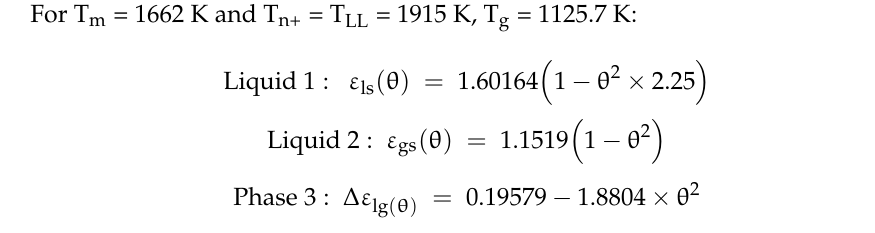
Figure 18. Enthalpy coefficient Δε lg (T) of Fe 2 B Phase 3 and configurons. T 3 = 903 K, T g = 1125.7 K, T m = 1662 K, T n+ = T LL = 1915